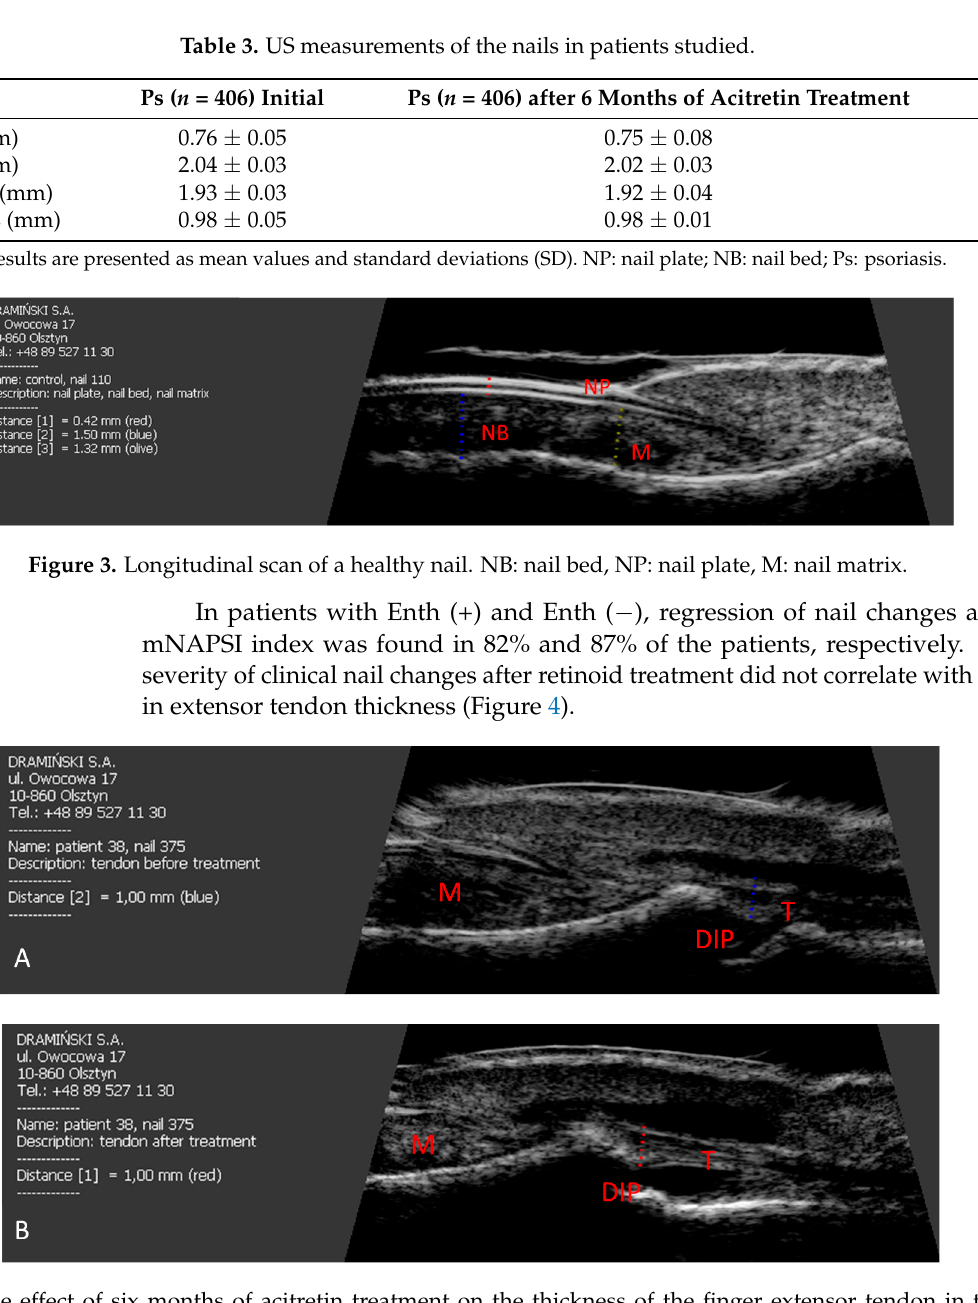
Figure 4. The effect of six months of acitretin treatment on the thickness of the finger extensor tendon in the distal interphalangeal joint in patients studied. ( A ) Before treatment. ( B ) After six months of acitretin treatment. M: nail matrix, T: finger extensor tendon, DIP: distal interphalangeal joint.